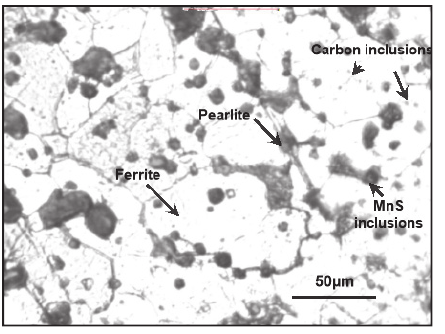
Fig. 1. Flow chart for the correction of the roll forming process design